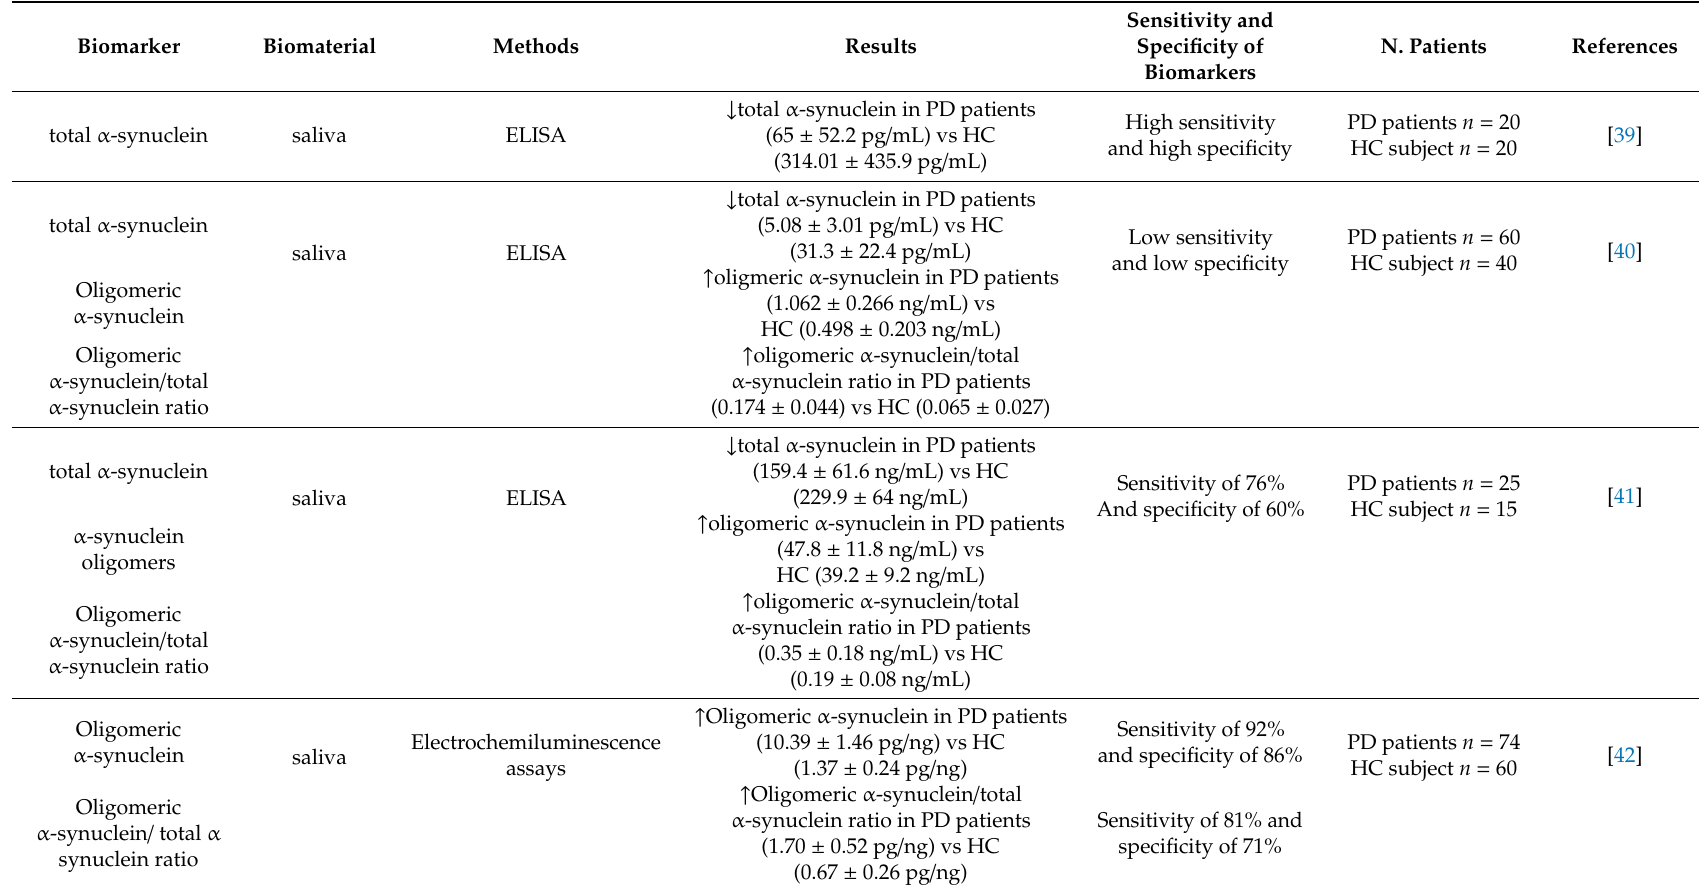
Table 2. Salivary biomarkers associated with Parkinson’s disease (PD) reported in clinical